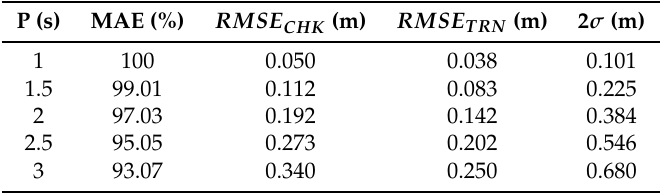
Table 5. ANFIS performance for predicting TMS depth up to P = 3 s in future.